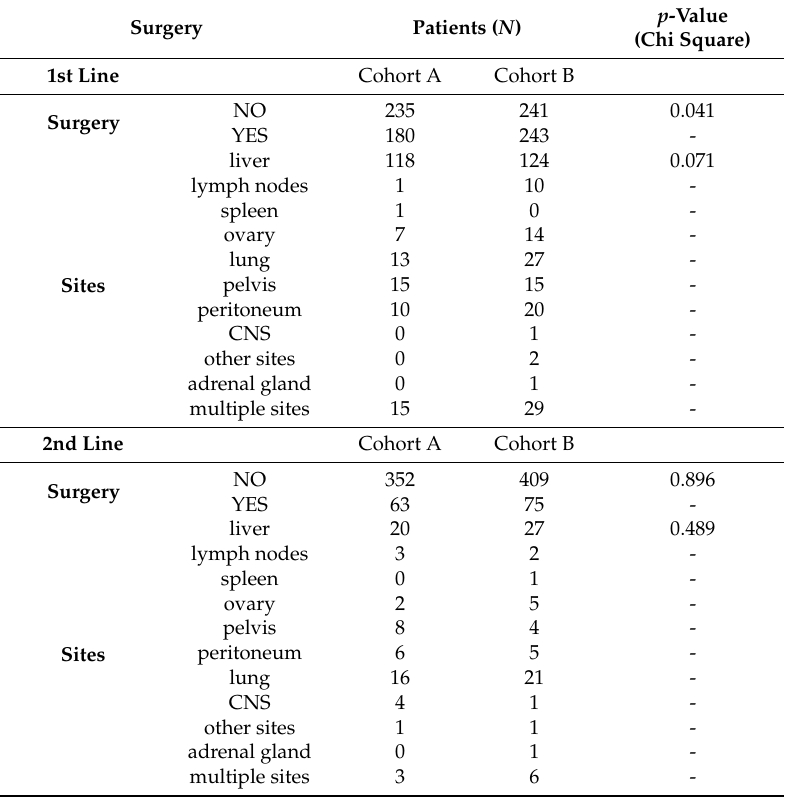
Table 3. Surgery sites and